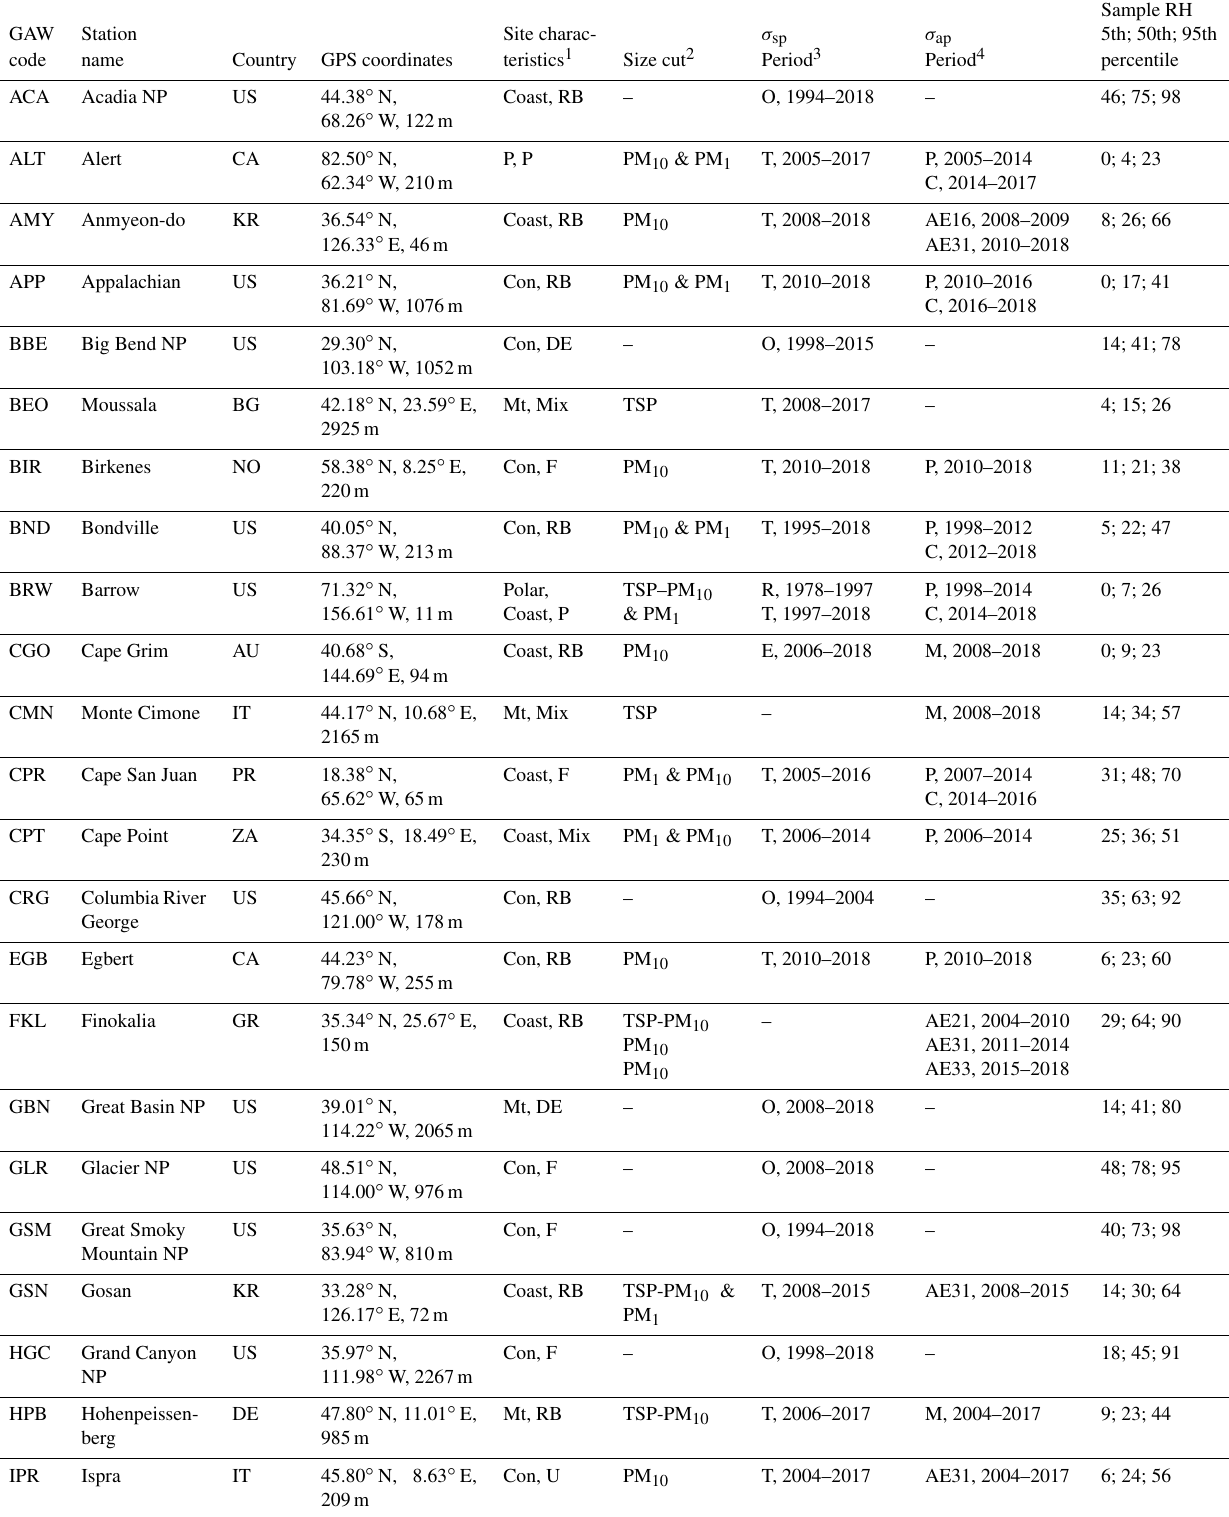
Table 1. List of observatories included in this study, arranged alphabetically by Global Atmospheric Watch (GAW) acronyms, including their names, countries, coordinates and elevation, site environmental characteristic (geographical category and footprint), size cut, type of nephelometer and absorption filter photometer deployed, time period used, and nephelometer RH